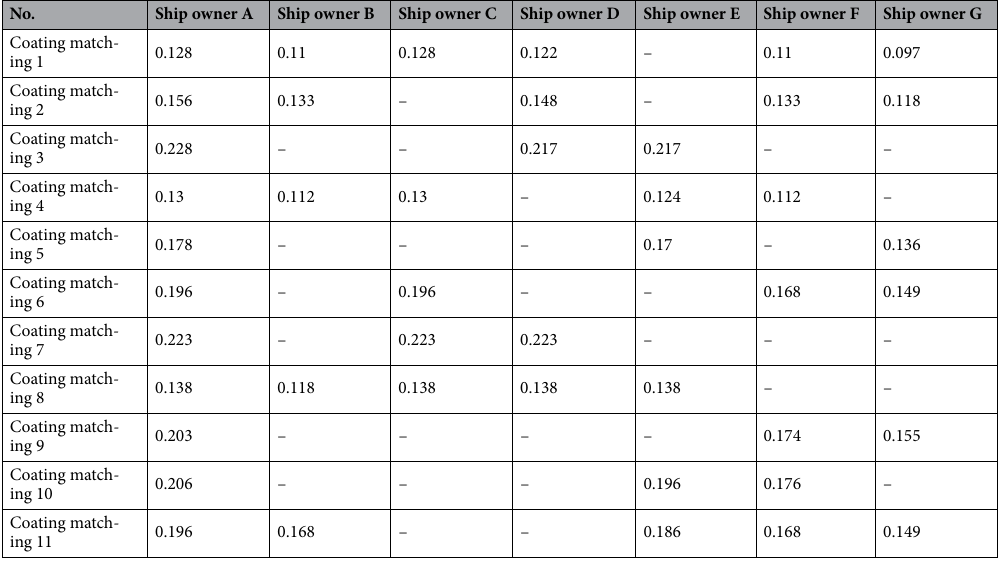
Table 10. Partial coating matching scoring